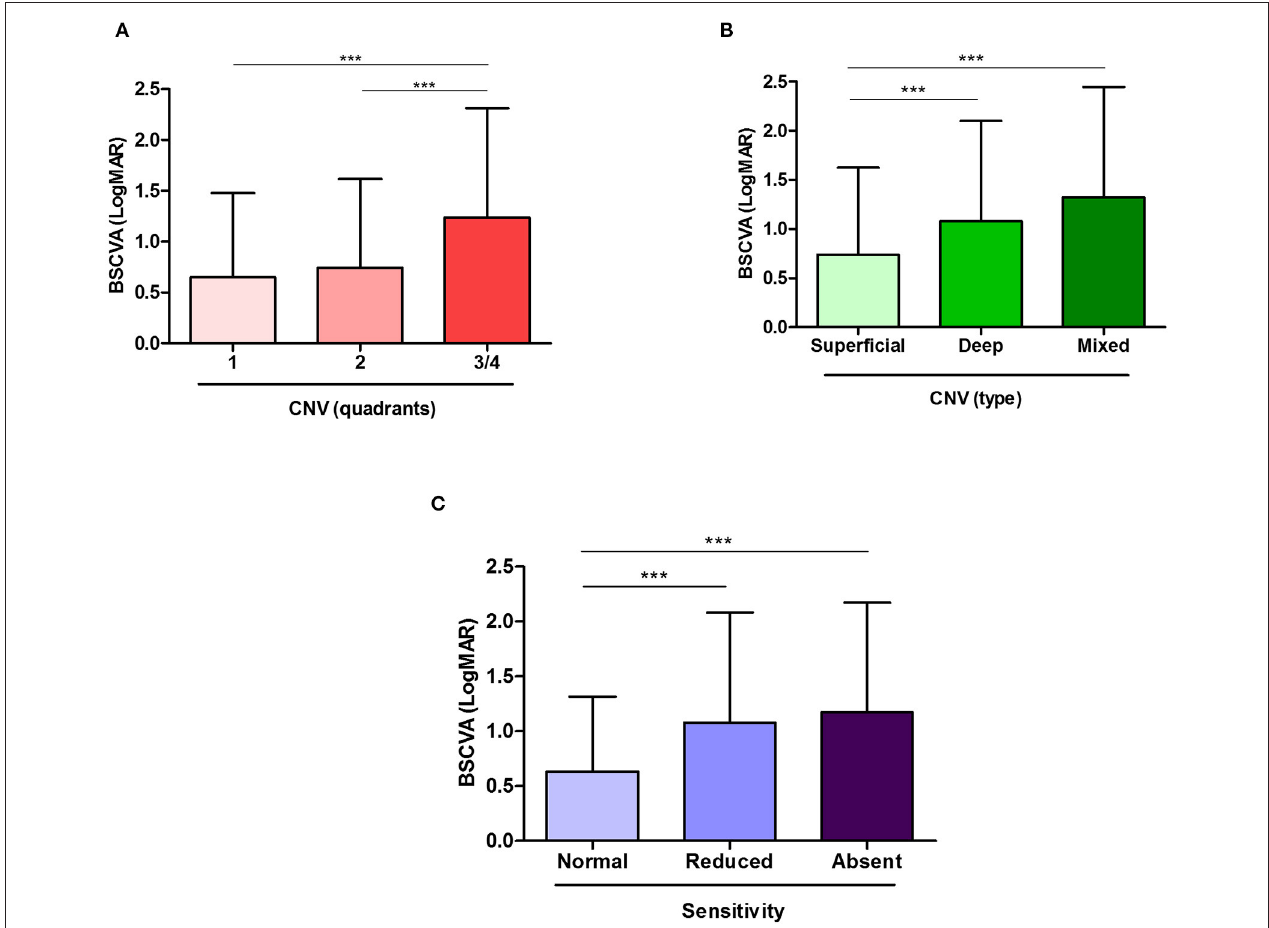
FIGURE 2 | Visual acuity is affected by the extent of corneal neovascularization (cNV) and the decrease in corneal sensitivity. Worse best spectacle corrected visual acuity (BSCVA), observed as an increase in logMAR, is associated with increasing cNV extent (A) and location (B) . In addition, the patients with reduced or absent corneal sensitivity showed worse BSCVA (C) . Results are expressed as mean ± SD. Statistical analysis was performed by using multiple comparison tests of the Kruskal–Wallis and Dunn’s. *** p <